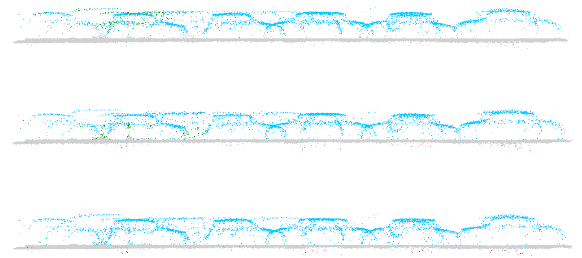
Figure 5 . Separability of vehicle and ground points given by PointNet++ without any changes (top), with prior knowledge (middle) and with additional 2D features (bottom) .